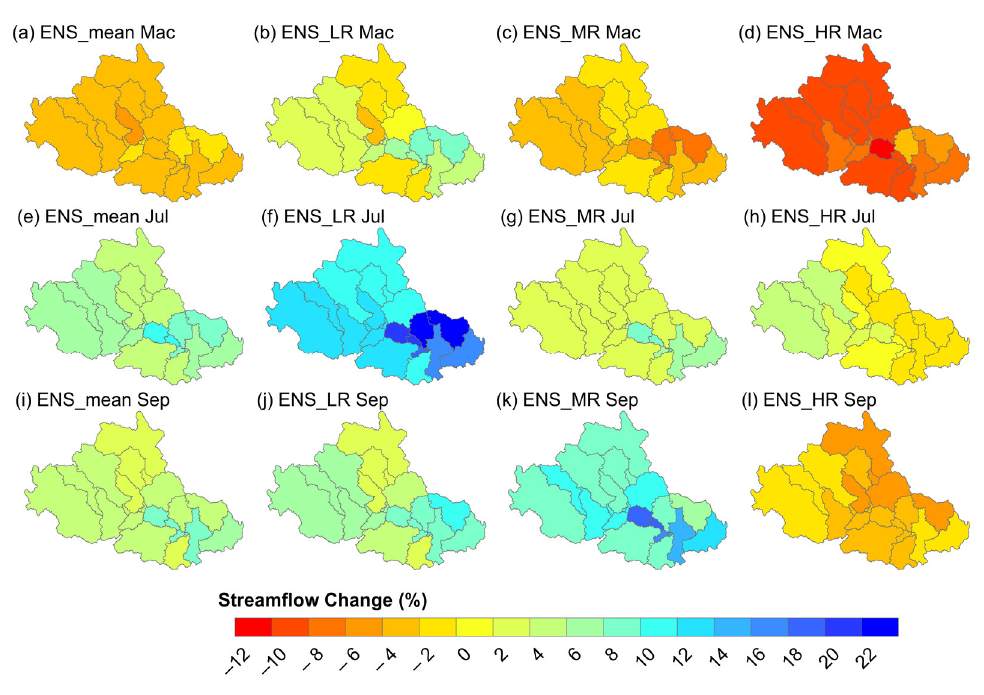
Figure 7. The spatial percent change of monthly streamflow during the dry periods of March ( a , b , c , d ), July ( e , f , g , h ) and September ( i , j , k , l ) projected by the CMIP6 HighResMIP models.